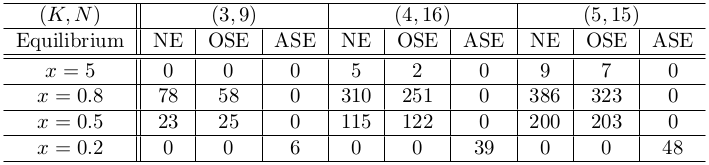
Table from the paper: Self-Optimized OFDMA via Multiple Stackelberg Leader Equilibrium
Table text:
(K,N)
(3,9)
(4,16)
(5,15)
Equilibrium
NE
OSE
ASE
NE
OSE
ASE
NE
OSE
ASE
x=5
0
0
0
5
2
0
9
7
0
x=0.8
78
58
0
310
251
0
386
323
0
x=0.5
23
25
0
115
122
0
200
203
0
x=0.2
0
0
6
0
0
39
0
0
48